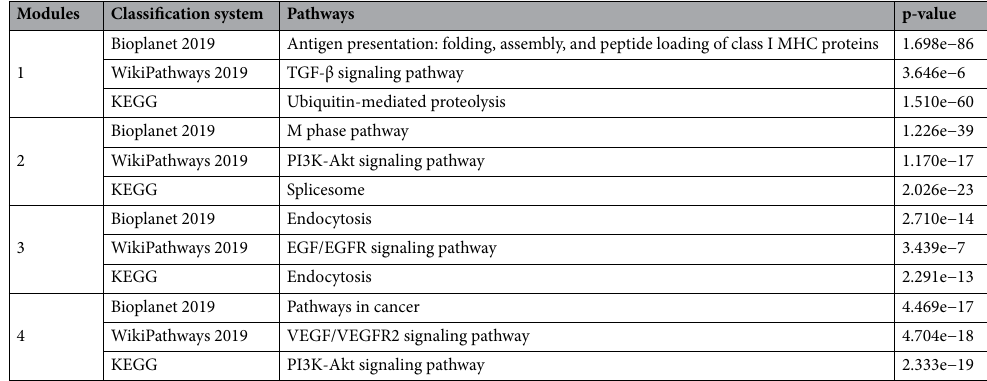
Table 3. GO and pathway enrichment analysis of top four modules in the PPI network of genes predicted to be targeted by enoxacin-induced miRNAs.